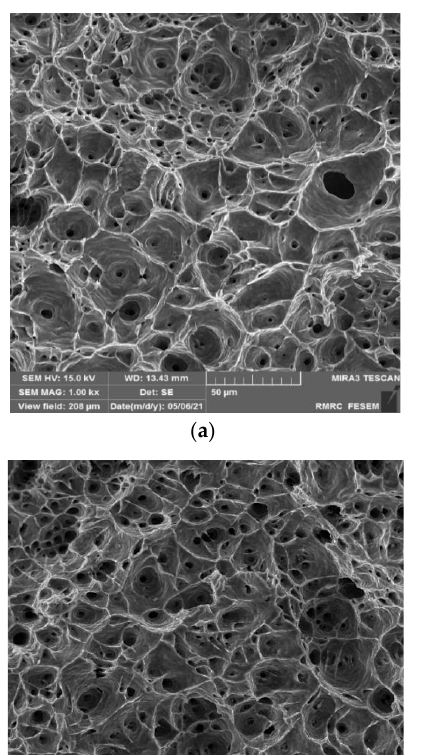
Figure 7. Comparison of tensile properties of Al and Al – 0.5 wt% GNPs at a temperature of ( a ) 20 °C ( b ) 180 °C.